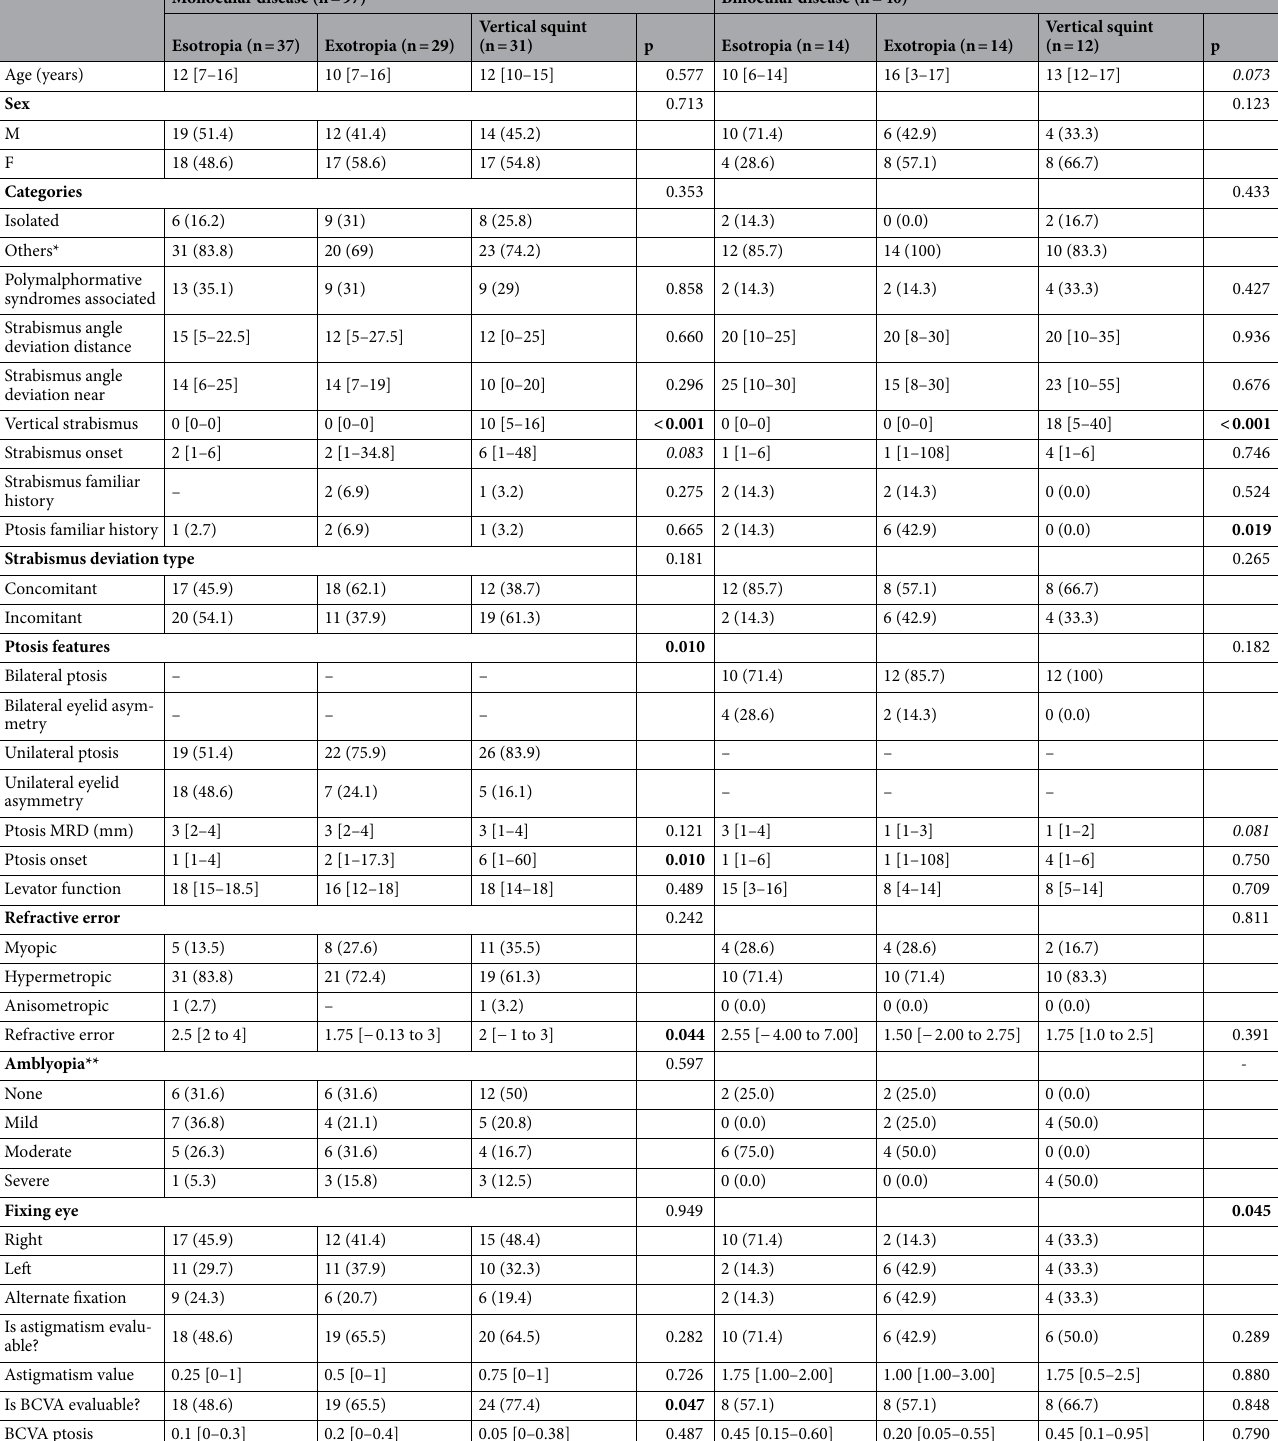
Table 2. Association between strabismus type and general and clinical characteristics in the study cohort, according to patients’ subgroups (n = 137). M male, F female, MRD margin reflex distance, BCVA